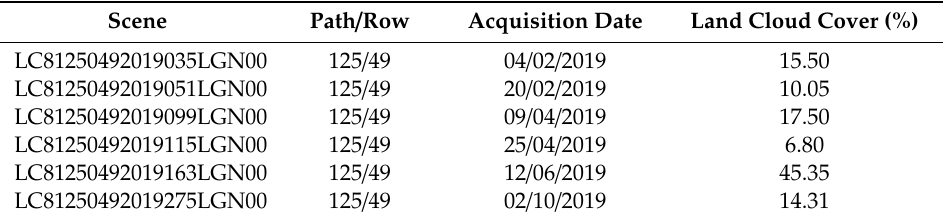
Table 2. The Landsat 8-OLI images